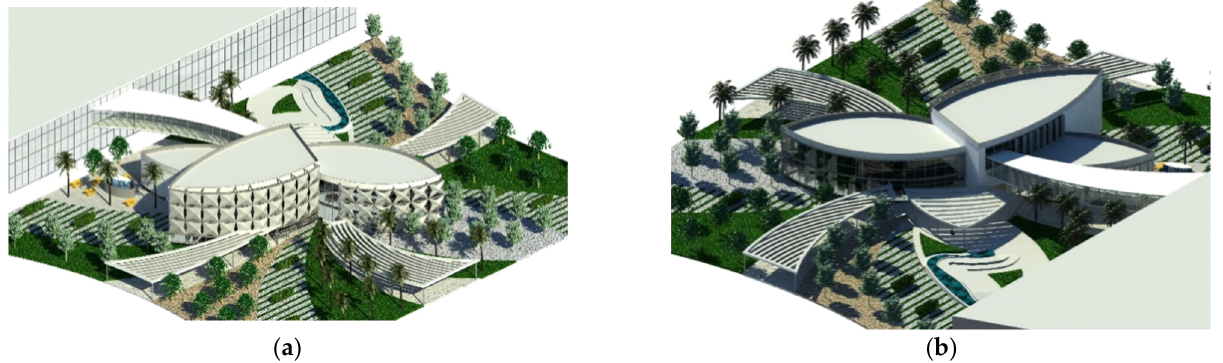
Figure 11. 3D rendered eye bird Views ( a ) south view, ( b ) north view.